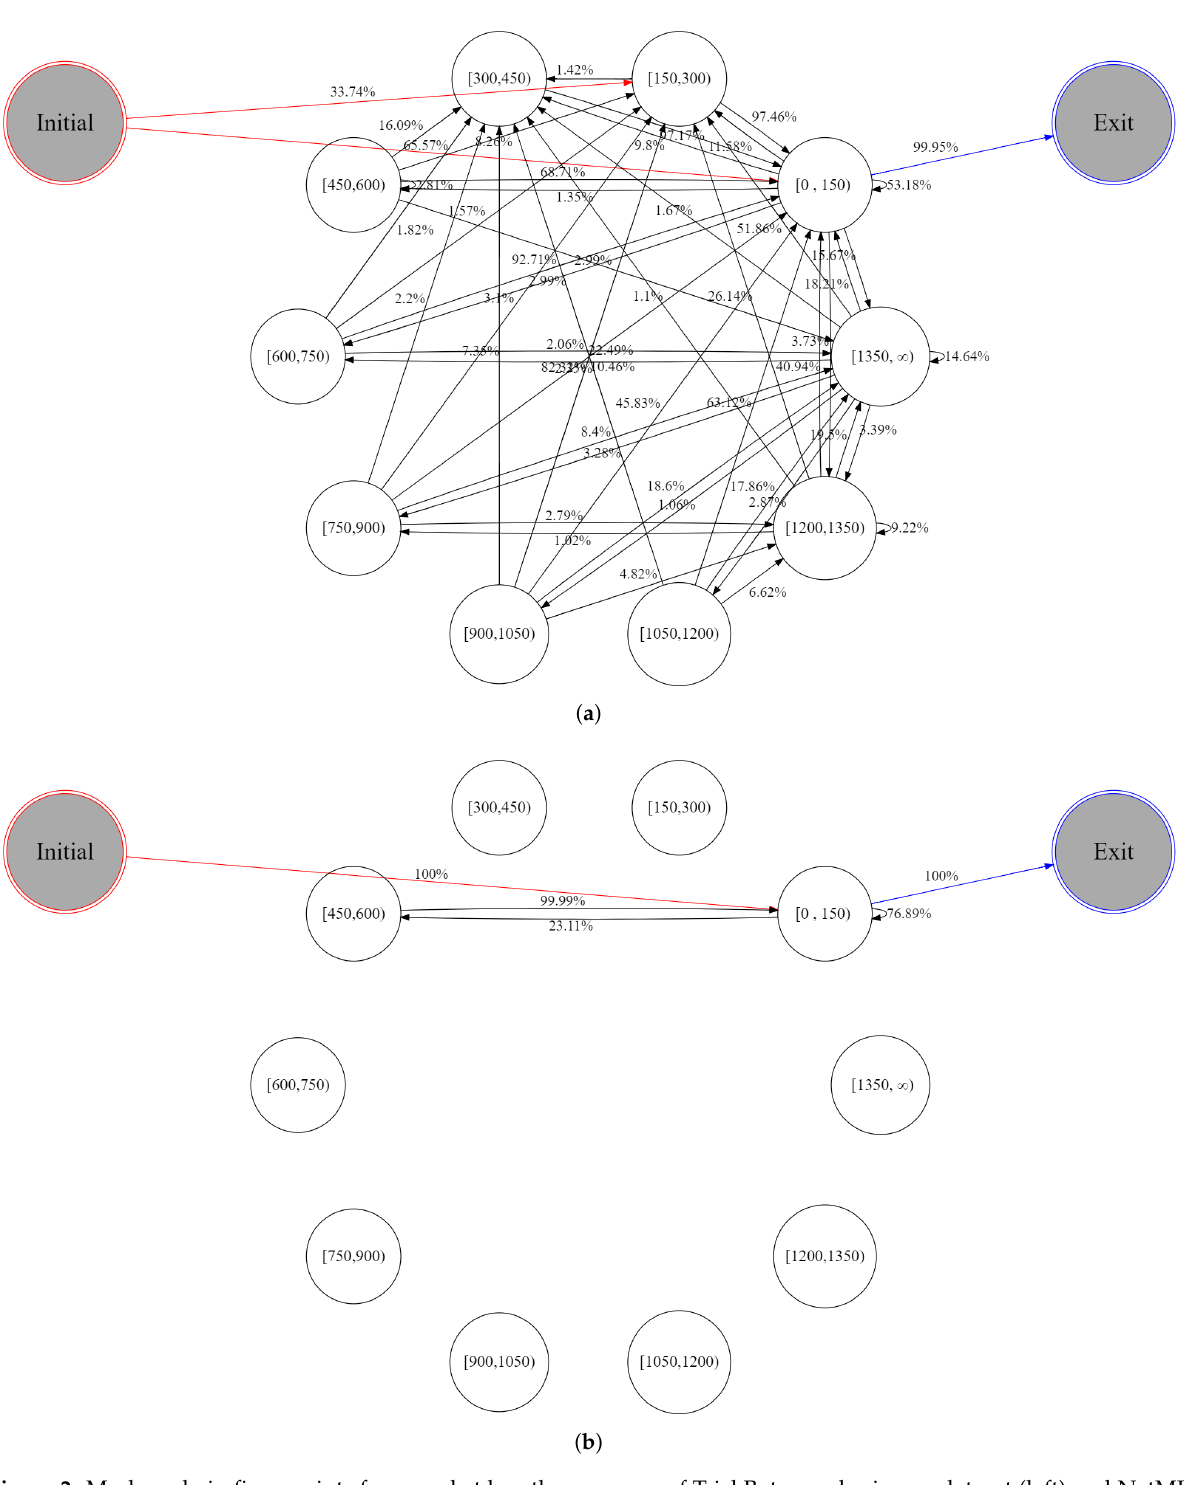
Figure 2. Markov chain fingerprints from packet length sequences of TrickBot samples in our dataset (left) and NetML 2020 dataset (right). Note that for simplicity, edges with <1% state transition probability are removed in ( a ). ( a ) TrickBot fingerprint generated from our dataset, ( b ) TrickBot fingerprint generated from NetML 2020